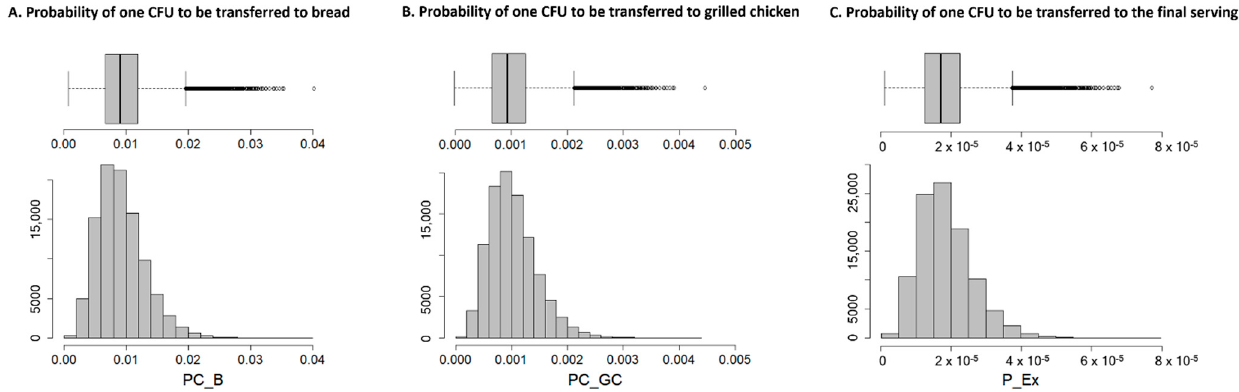
Figure 2. Estimated relative frequencies on the probabilities of one CFU of ESBL-/AmpC-producing E. coli transferring to ( A ) bread (PC_B), ( B ) grilled chicken (PC_GC) and ( C ) the final serving (P_Ex), due to the cross-contamination and recontamination processes contemplated in the model. Table 2. Model estimates on the probabilities of one CFU of ESBL-/AmpC-producing E. coli transferring from raw chicken meat to bread (PC_B), grilled chicken (PC_GC) and final serving (P_Ex), and the number of CFU transferred from raw chicken meat to bread (N_B), grilled chicken (N_GC) and final serving (N_Ex). Minimum